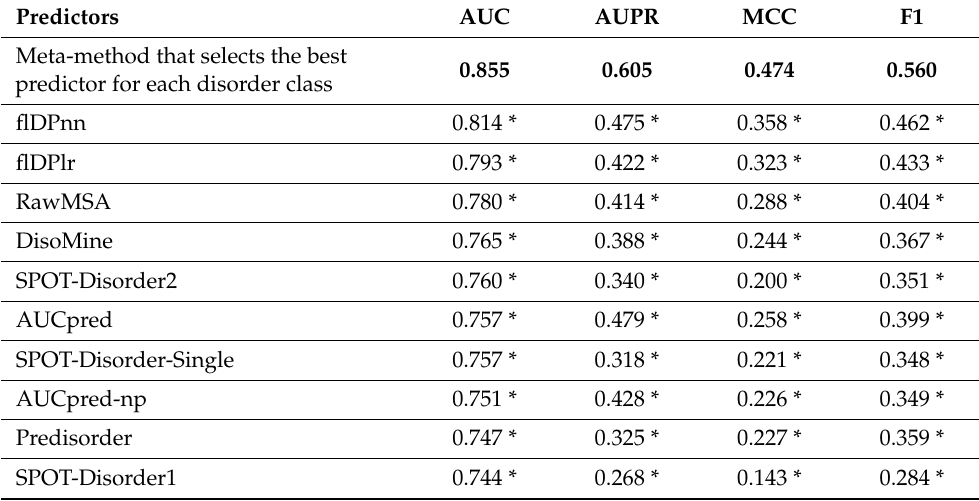
Table 3. Predictive performance measured with AUC, AUPR, MCC and F1 for the top ten disorder predictors and the meta-method on the CAID dataset. The bold font identifies the highest value for a given metric. “*” means that the difference between the best-performing meta-method and a given disorder predictor is statistically significant at p -value of 0.05. Methods are sorted by their AUC